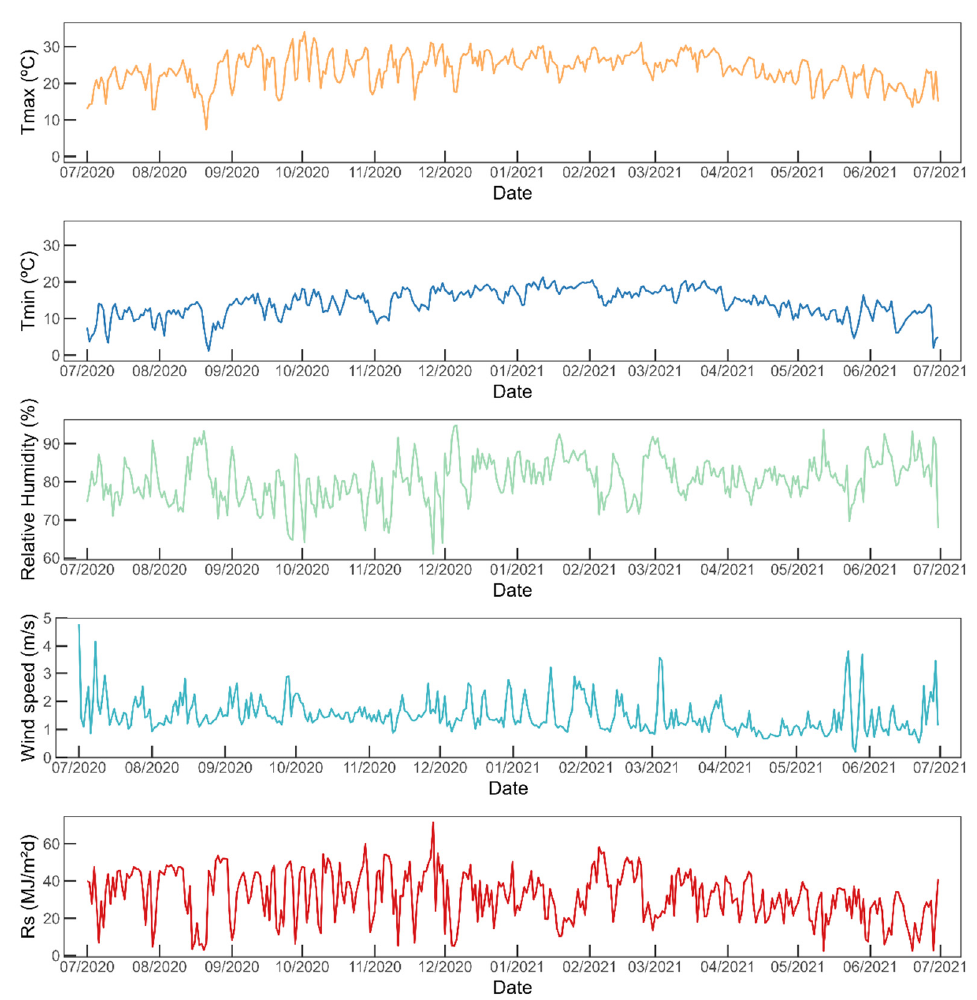
Figure 3. Weather data from the study site (1 July 2020 to 30 June 2021). A maximum temperature of 34.13 °C and a minimum temperature of 1.14 °C was observed from the dataset. The relative humidity ranges from 61.12% to 94.72%, and the wind speed from 0.21 m s − 1 to 4.16 m s − 1 . The solar radiation average for the region is 31.96 MJ m − 2 day − 1 or 369.91 W m − 2 .